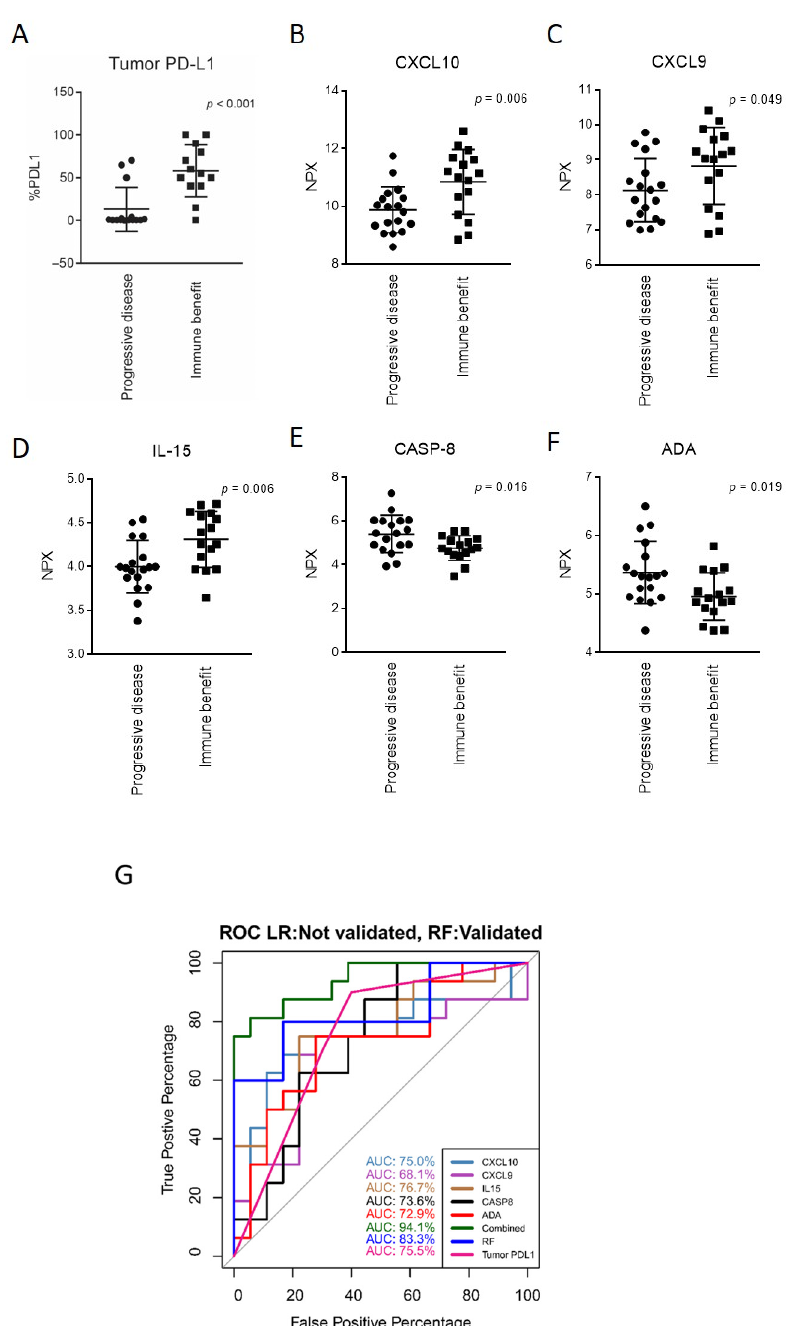
Figure 4. Tumor PD-L1 expression and plasma protein levels at the baseline and the development of the discriminatory model. The population ( n = 43) was stratified into two groups: immune benefit (including stable disease and partial response) and progressive disease (including patients with progressive disease). ( A ) Comparison of tumor PD-L1 expression, assessed by immunohistochemistry, before the initiation of anti-PD-(L)1 therapy between the immune benefit and progressive disease groups. ( B – F ) Plasma proteins with differential expression before the initiation of anti-PD-(L)1 therapy. A two-tailed unpaired t-test or two-tailed non-parametric Mann-Whitney test was used. Only proteins with a p -value < 0.05 are displayed. Data are plotted as %PD-L1 or normalized protein expression (NPX). ( G ) Receiver operating characteristic (ROC) curves illustrating the discriminatory model for CXCL10, CXCL9, IL-15, CASP8, and ADA individually or combined and tumor PD-L1. A random forest model containing all 84 proteins was also evaluated.